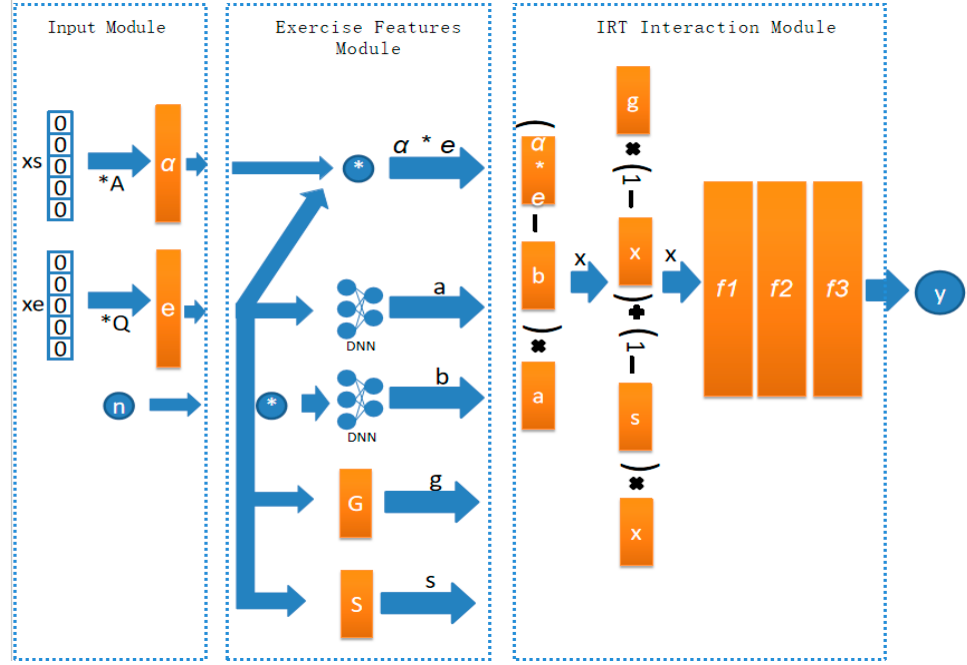
Figure 1. Framework diagram of NeuralNCD model. Where * is the multiplication of vectors.